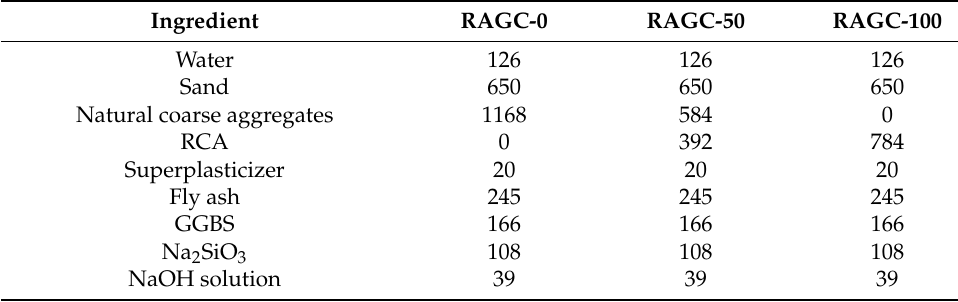
Table 2. Mix proportions for RAGC (kg/m 3 ).